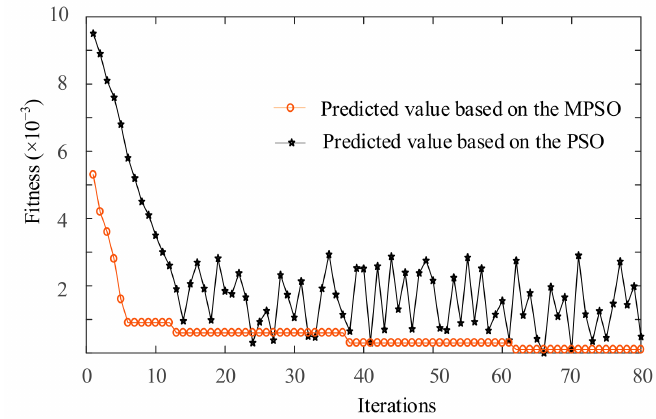
Figure 4. Mean square error curves of MPSO and PSO.